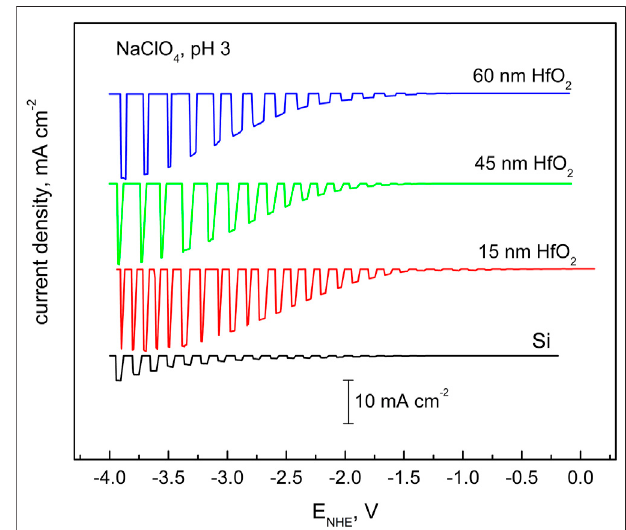
FIGURE 6 | Cathodic photocurrents of hydrogen reduction over wide region of cathodic voltages obtained for p -Si – H electrode prepared by treatment in HF solution (marked as Si) and that coated with HfO 2 layer with different thickness. Electrolyte: 1 M NaClO 4 (pH 3). The illumination of 505-nm wavelengths and intensity of 50 mW cm − 2 have been chopped at certain intervals. The potential sweep rate was 5 mV s − 1 .